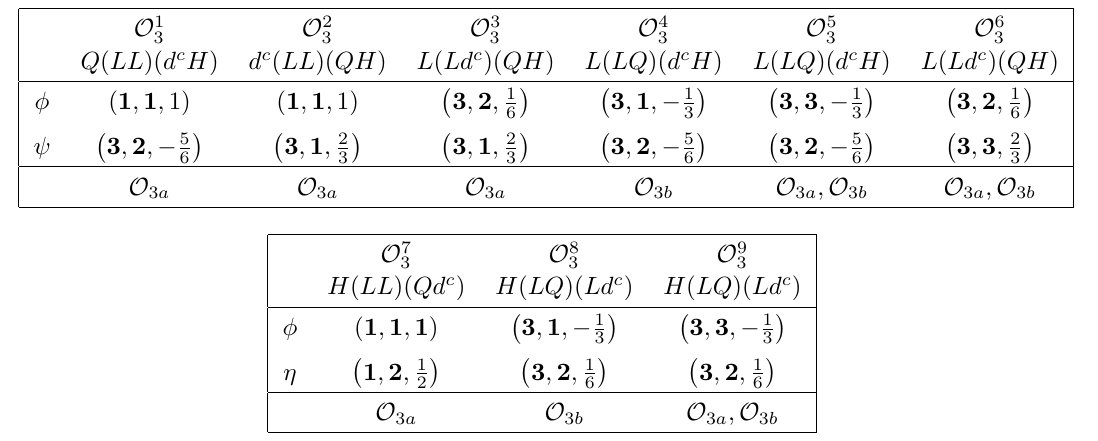
Table 3 . Minimal UV completions of operators segment require a new scalar (cid:30) and a vectorlike fermion , while those in the lower segment require